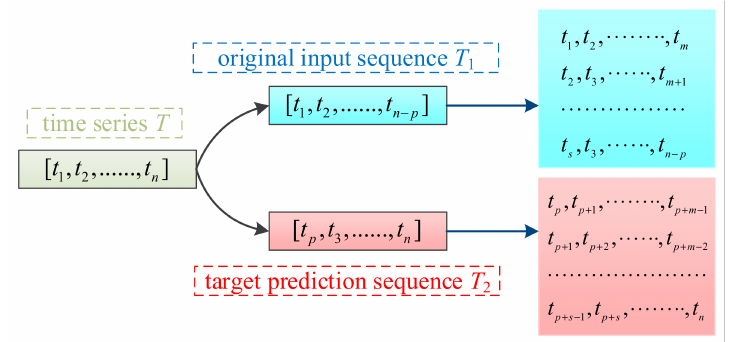
Figure 4. Schematic diagram of time series